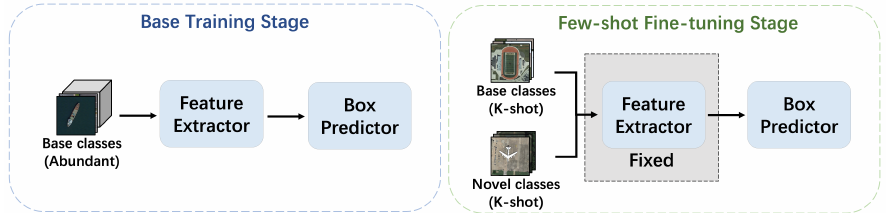
Figure 2. Framework of the Two-stage Fine tuning Approach